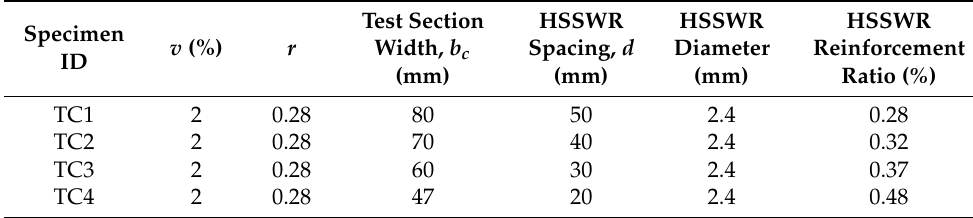
Table 6. HSSWR-ECC Specimen parameter